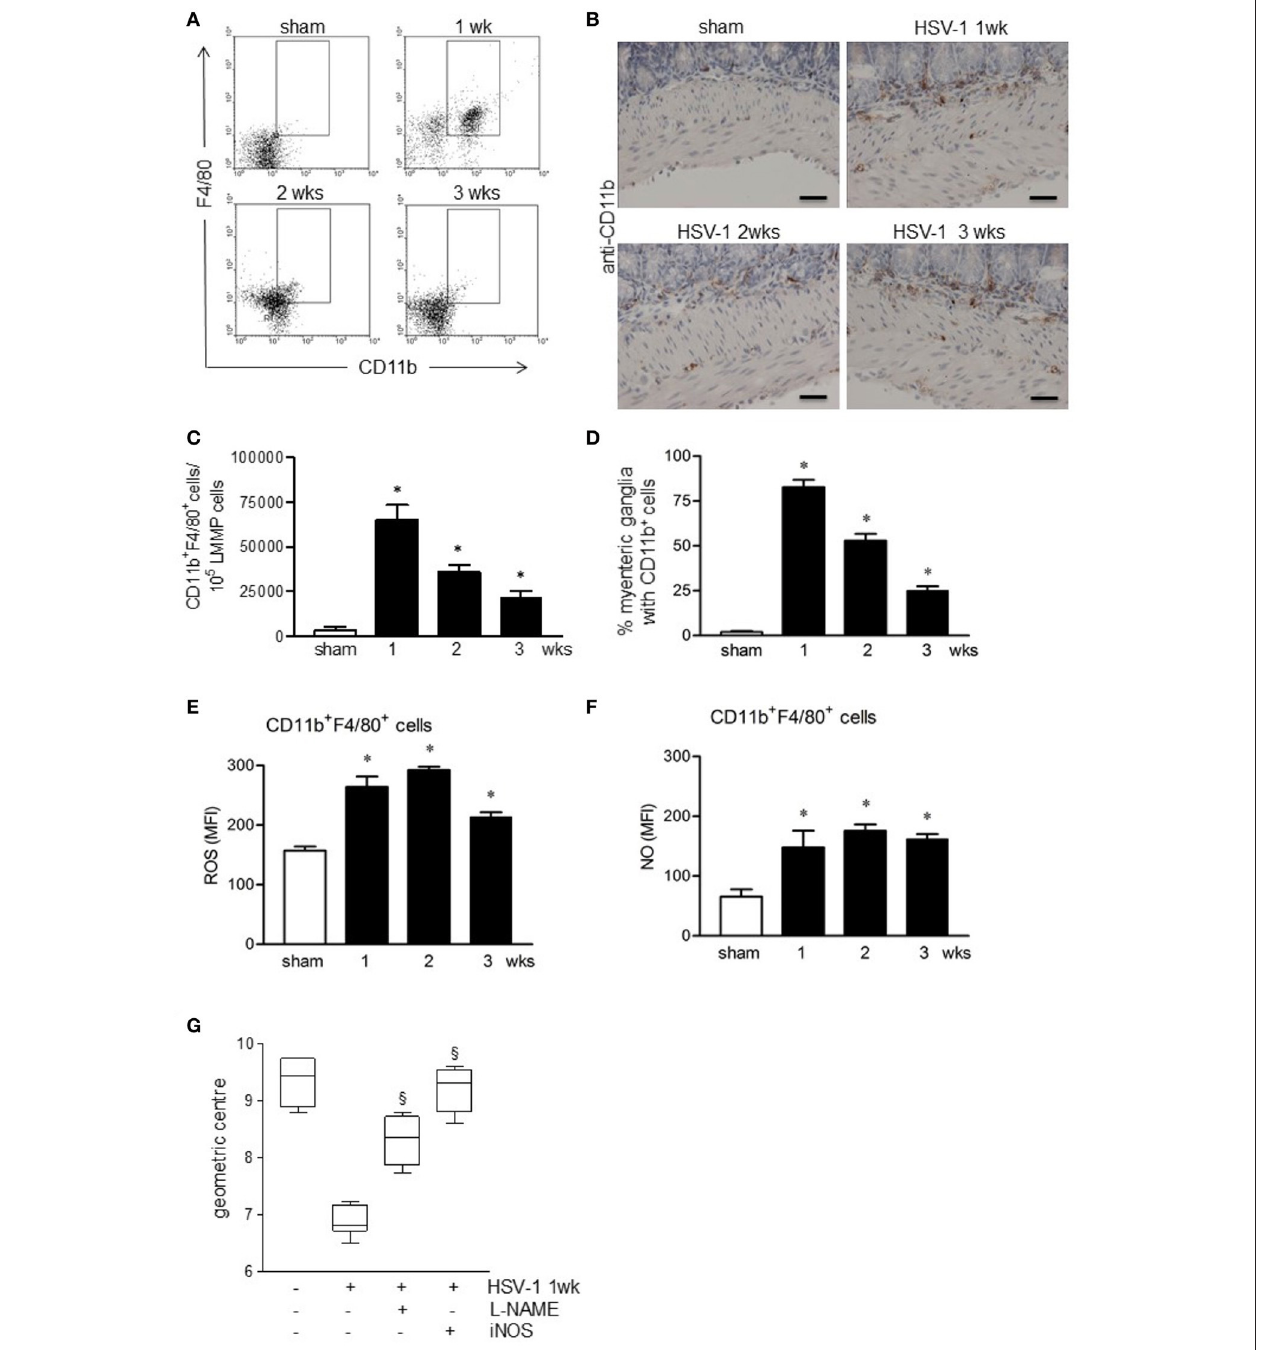
FIGURE 6 | Activated macrophages infiltrate and damage the ENS of HSV-1 infected mice. (A) Freshly collected LMMP were digested and the resulting cell suspensions were labeled with anti-CD11b and anti-F4/80 antibodies and analyzed by flow cytometry. Representative images of five separate experiments. (B) Immunohistochemistry for CD11b on sections of ileum. Representative images of three separate experiments. Scale bars: 40 µ m. (C) CD11b + F4/80 + cells analyzed by flow cytometry as in (A) were enumerated in 10 5 collected events. (D) Myenteric plexuses reporting juxtaposed CD11b + cells as in (B) were counted and normalized to the number of total myenteric plexuses. Data are reported as percentage. (E) Cells obtained from LMMP were incubated for 30min at 37 ◦ C with H 2 DCFDA, a probe detecting intracellular ROS or (F) with DAF-FM to detect intracellular NO. Cells were then labeled with anti-CD11b and anti-F4/80 antibodies. Mean fluorescent intensity (MFI) was detected by flow cytometry in 10.000 events. n = 3–9 mice per group. *Denotes P < 0.01 compared to sham infected mice. (G) Mice infected with HSV-1 strain 16 were intraperitoneally injected with L-NAME, a pan-NOS inhibitor, or with iNOS inhibitor (AR-C102222). At 1-week of infection, mice were administered with non-absorbable FITC-labeled dextran and sacrificed 60min later. Intestinal transit was reported as the geometric center of distribution of the fluorescent probe throughout the ileum. Data are represented as mean ± SEM. n = 6 mice per group. § Denotes P < 0.05 compared to 1-week HSV-1 infected mice.